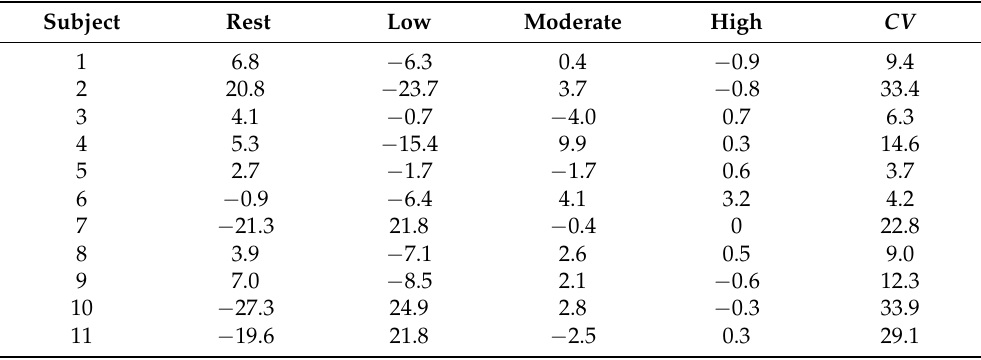
Table 3. Detection errors (in minute) per subject and per activity and corresponding coefficient of variation ( CV ) in %.